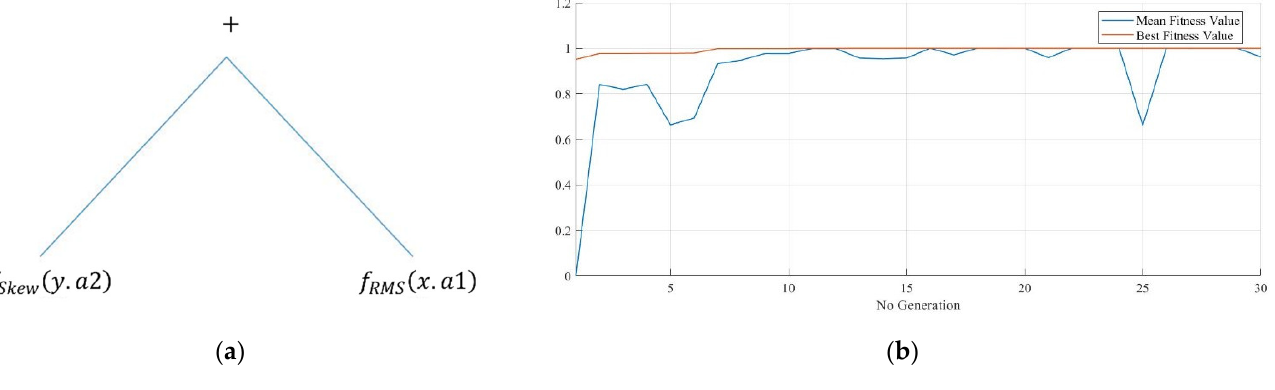
in Equation (8) and shown in Figure